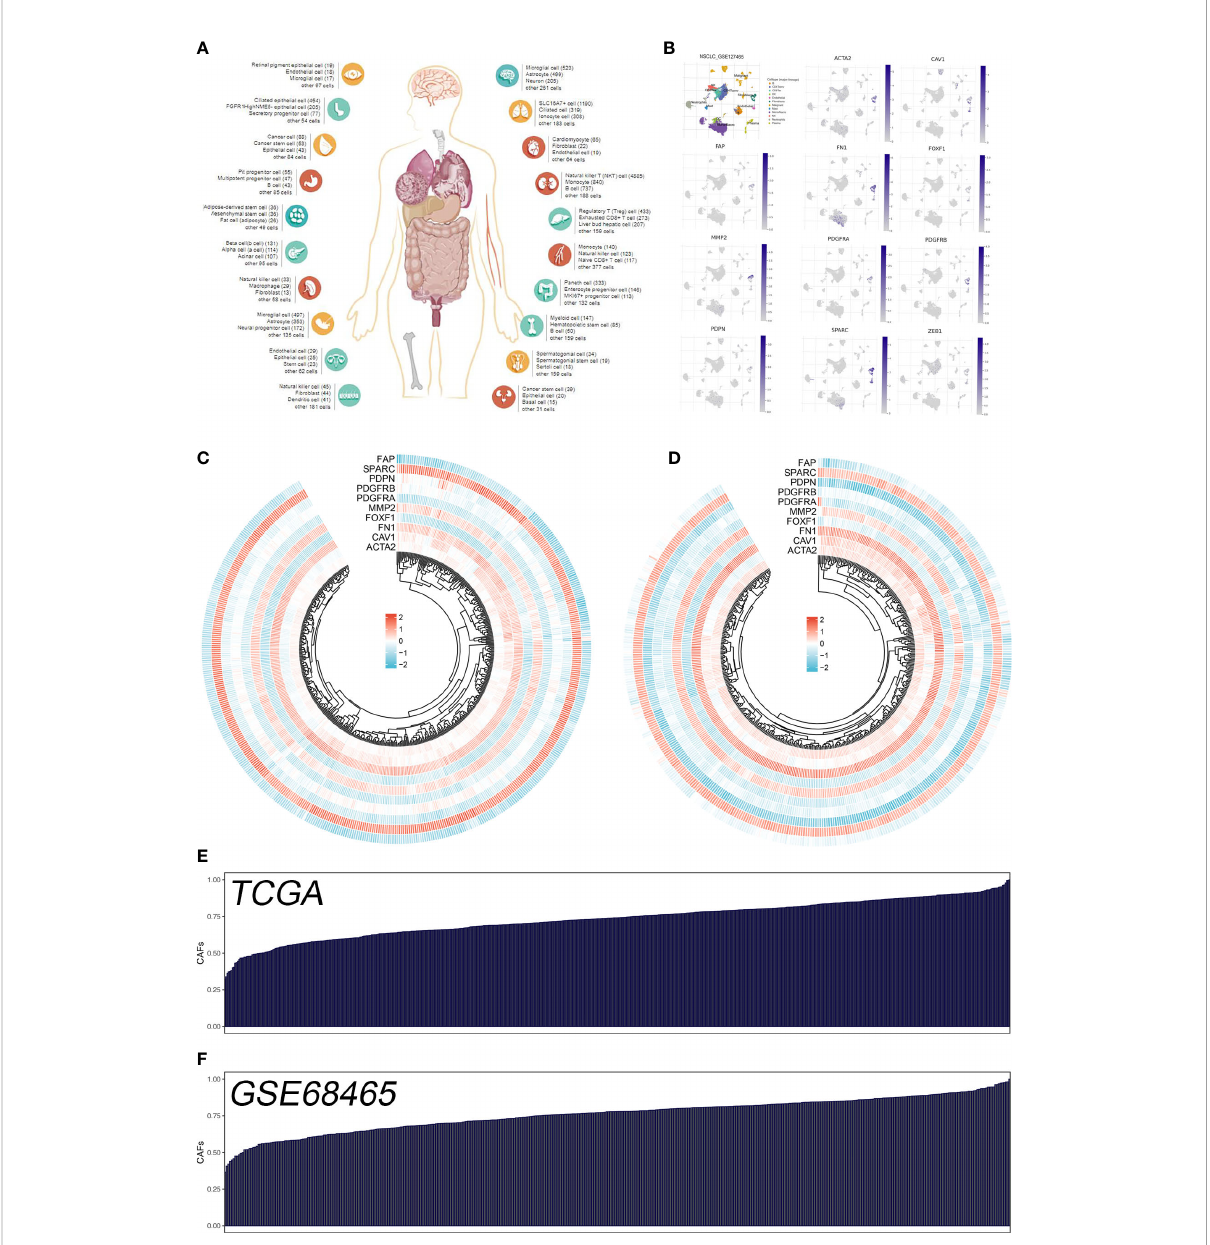
FIGURE 1 Quanti fi cation of the CAFs in fi ltration based on identi fi ed markers. (A) The human single-cell atlas from the online website Cell Marker, http:// bio-bigdata.hrbmu.edu.cn/CellMarker/; (B) The expression map of marker genes in different subgroup cells; (C) The heatmap demonstrated the expression of CAFs marker genes in TCGA cohort; (D) The heatmap demonstrated the expression of CAFs signature genes in GSE68465 cohort; (E) CAFs score in TCGA cohort quanti fi ed by ssGSEA; (F) CAFs score in GSE68465 cohort quanti fi ed by